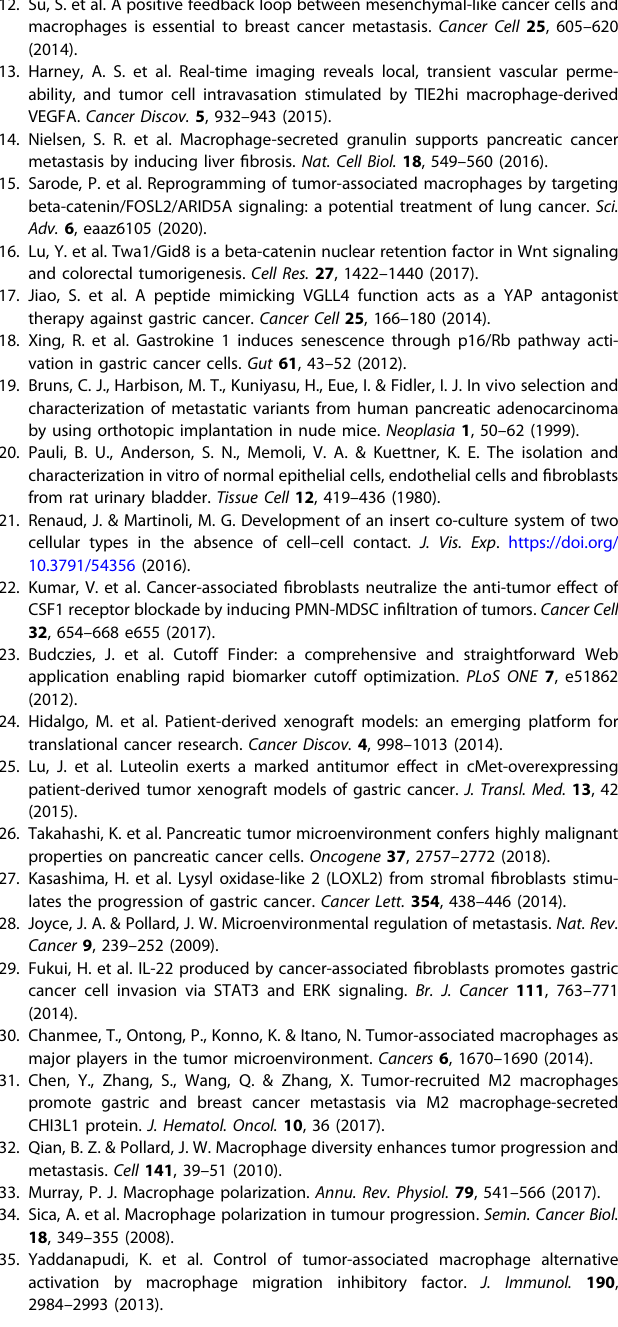
Fig. 7 TAM-induced EMT inhibits MAPK4 expression in gastric cancer cells. a BMDMs were cocultured or not cocultured with BGC-823 cells and subjected to qRT ‒ PCR analysis of Arg1 mRNA. b BGC-823 cells were cocultured or not cocultured with BMDMs and were used for the cell invasion assay. Scale bar, 200 μ m. c , d Cell morphology and western blot analyses of BGC-823 and MKN45 cells cocultured or not cocultured with BMDMs. Scale bar, 20 μ m. e BGC-823 cells were transfected with the indicated siRNAs and subjected to western blotting with the indicated antibodies. f , g Quantitative RT-PCR analysis of MAPK4 and E-cadherin in BGC-823 cells transfected with the indicated siRNAs. h BGC-823 cells transfected with the indicated siRNAs were subjected to western blotting. i Immunohistochemical analysis of E-cadherin in a human gastric tumor tissue array. Representative photographs of immunohistochemical staining in gastric cancer tissues (lower left) and adjacent nontumor tissues (upper left) are shown. Scale bar, 100 μ m. j Pearson correlation analysis of relative MAPK4 expression (tumor/ nontumor) from Fig. 1k and relative E-cadherin expression (tumor/nontumor) from ( i ). k Working model of MAPK4 downregulation-mediated positive feedback between cancer cells and macrophages to facilitate gastric cancer liver metastasis. The data are expressed as the means ± standard deviations. * p < 0.05, ** p < 0.01, *** p < 0.001; NS not signi fi cant (Student ’ s t